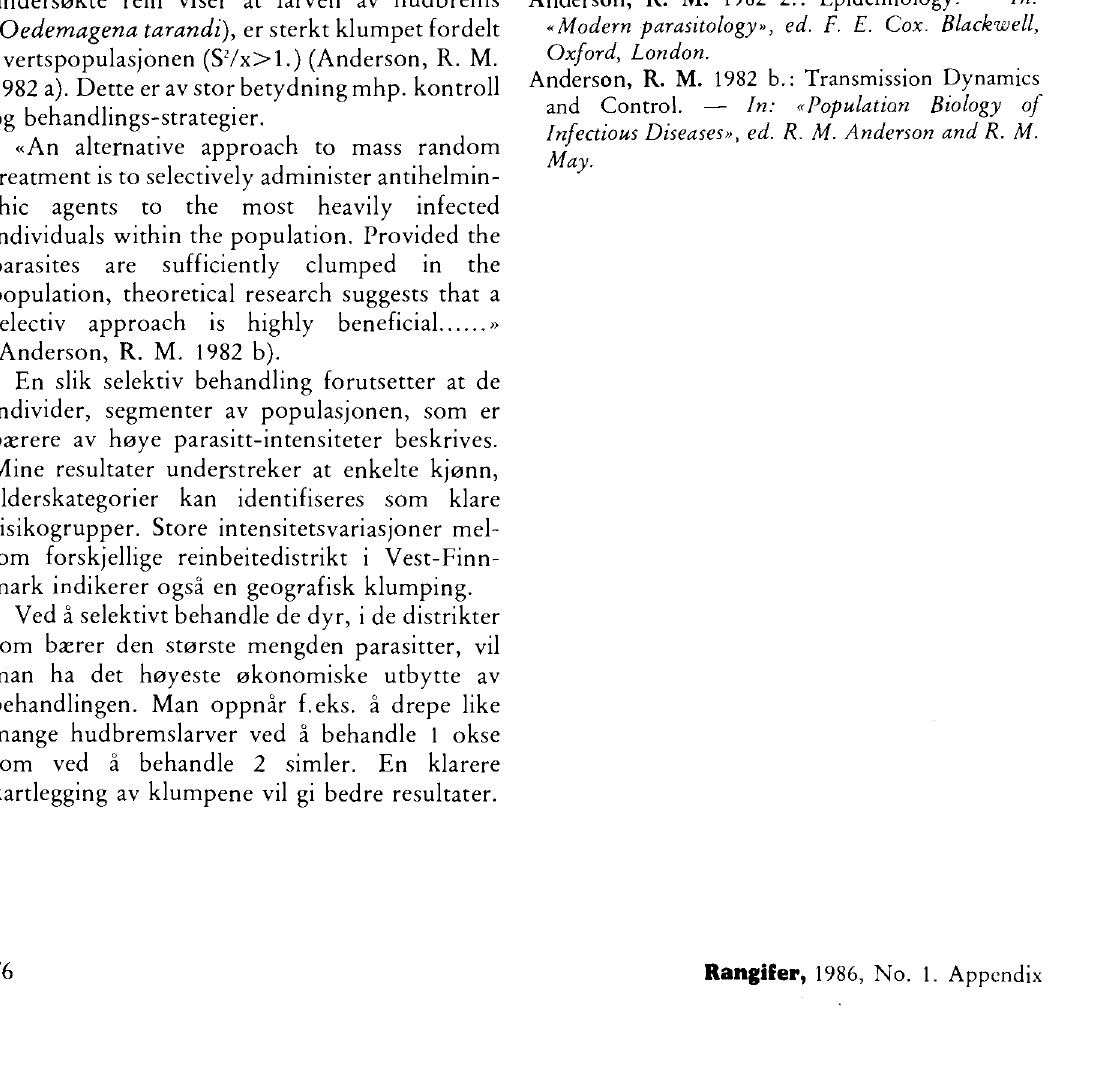
Fordeling av hudbrems i forskjellige distrikt, kjønn og aldersklasser av